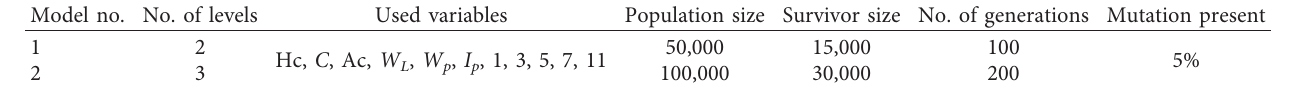
Table 3: Characteristics of the developed GP models.